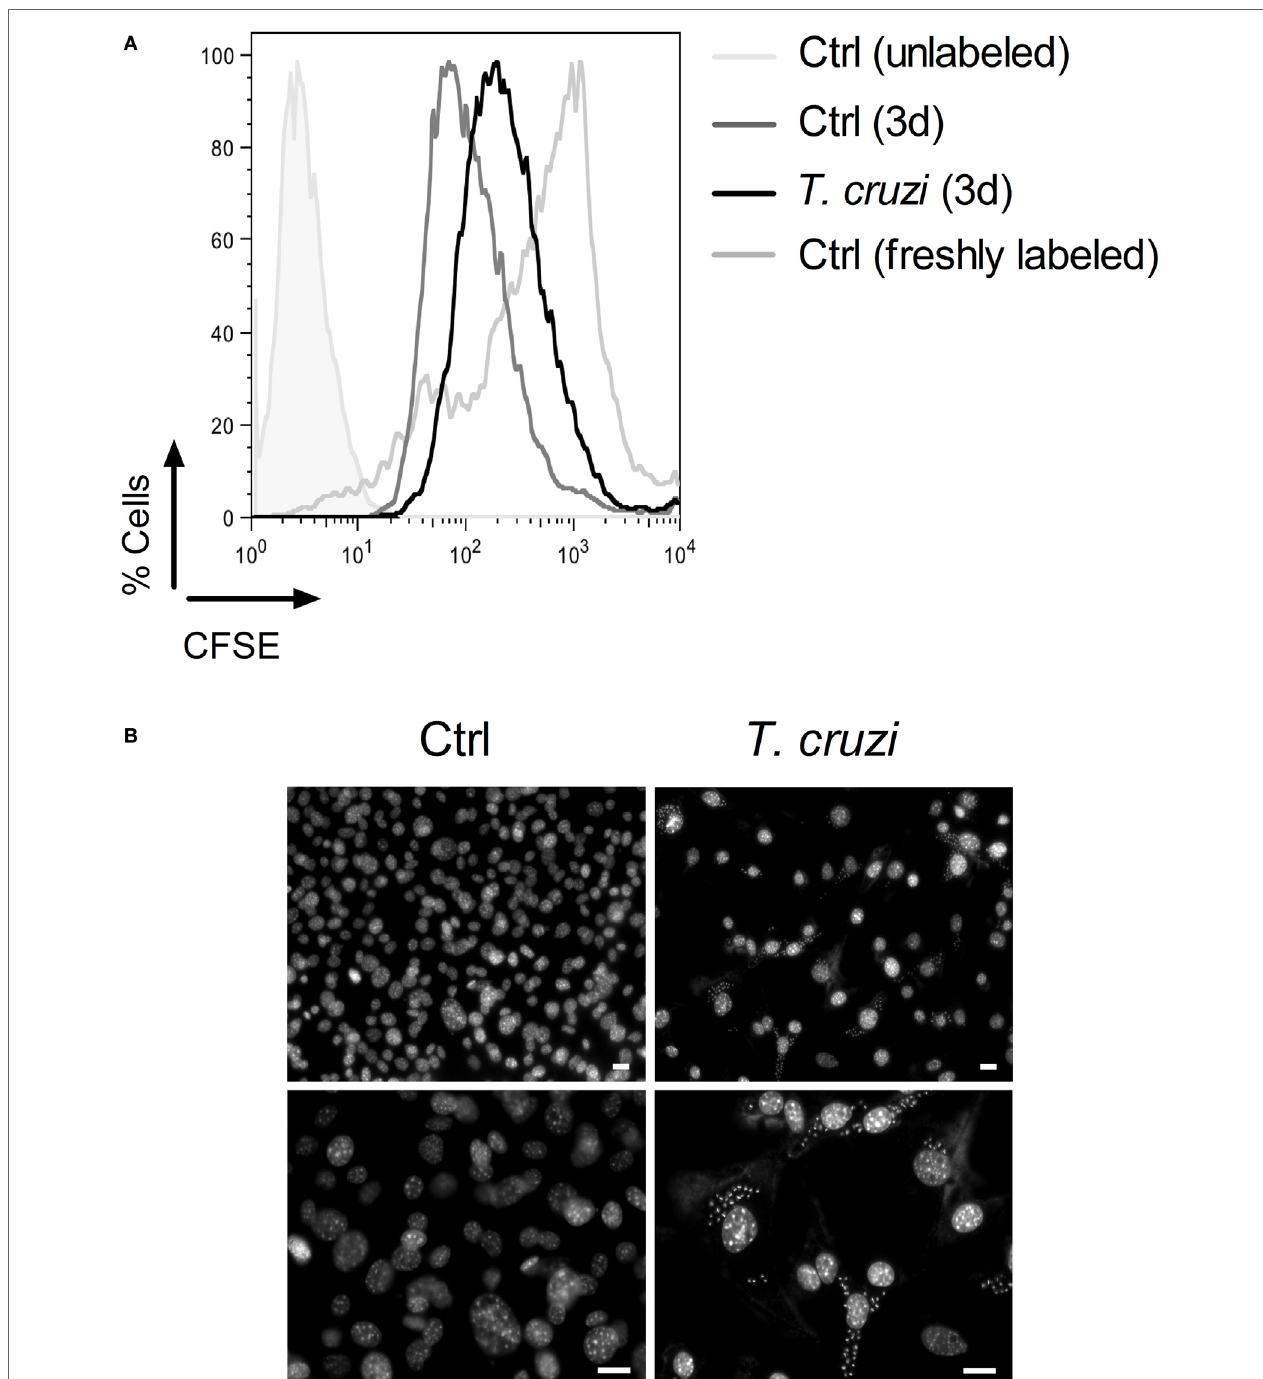
FigUre 2 | Trypanosoma cruzi infection inhibits fibroblasts proliferation and induces an accumulation of senescence-associated heterochromatin foci (SAHF). NIH-3T3 fibroblasts were infected with culture-derived T. cruzi trypomastigotes (MOI 5:1) overnight followed by a washing step to eliminate extracellular parasites. ( a) Assessment of cellular proliferative capacity in CFSE-labeled fibroblasts 3 days (3d) post-infection and before infection (0d) by flow cytometry. Fibroblasts were first gated based on FSC-A versus SSC-A parameters, and then CFSE staining was analyzed. (B) T. cruzi -infected and non-infected NIH-3T3 fibroblasts stained with DAPI (upper panels, 20 × magnification) 3 days post-infection. Enlarged images of DAPI staining are shown in the lower panels (40 × magnification). The fluorescence images were obtained and photographed from multiple fields, by using an Axioplan II microscope (Zeiss) and image pro-plus software version 7.0.1. Scale bars are equal to 20 µm. Data are representative of at least three independent experiments with similar results. Abbreviations: MOI, multiplicity of infection; Ctrl, control; CFSE, carboxyfluorsecein diacetate succinimidyl